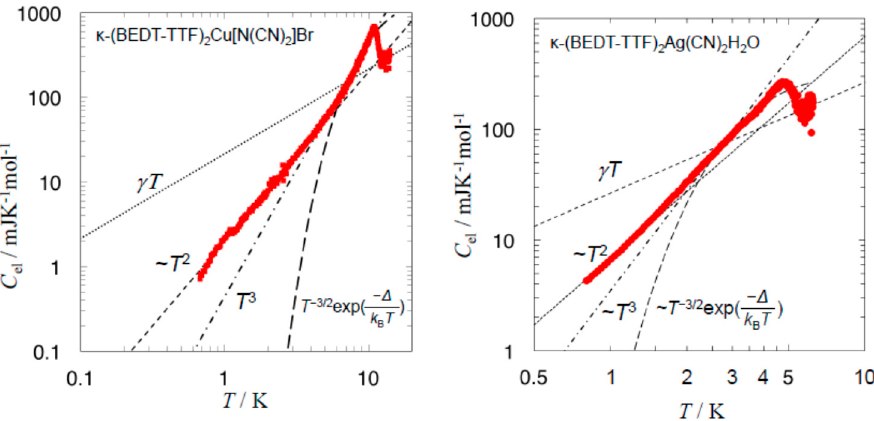
Figure 9. Temperature dependence of the electronic heat capacity determined as the difference of the 0-T data and the normal state data obtained under magnetic fields higher than H c2 for ( a ) κ -(BEDT- TTF) 2 Cu[N(CN) 2 ]Br and ( b ) κ -(BEDT-TTF) 2 Ag(CN) 2 H 2 O below the transition temperatures. (Ref. [60].) The lines and the curve shown in the figure denote T linear, T 2 , T 3 , and T − 3/2 exp( −Δ / k B T ) temperature dependence.